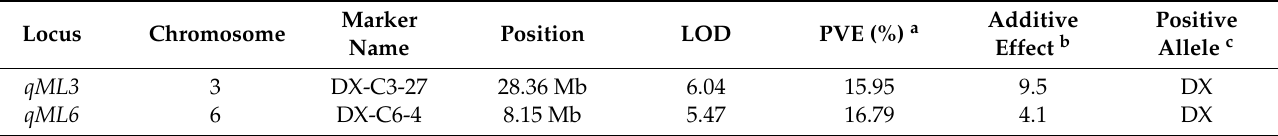
a Phenotypic variation explained by individual QTLs. b Estimated effect of replacing Nip alleles with Dongxiang common wild rice. c DX represents the positive effects of QTLs contributed by Dongxiang common wild rice alleles.